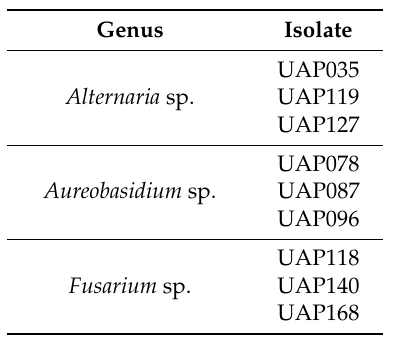
Table 2. Isolates evaluated in the pathogenesis assays and the genus phenotypically